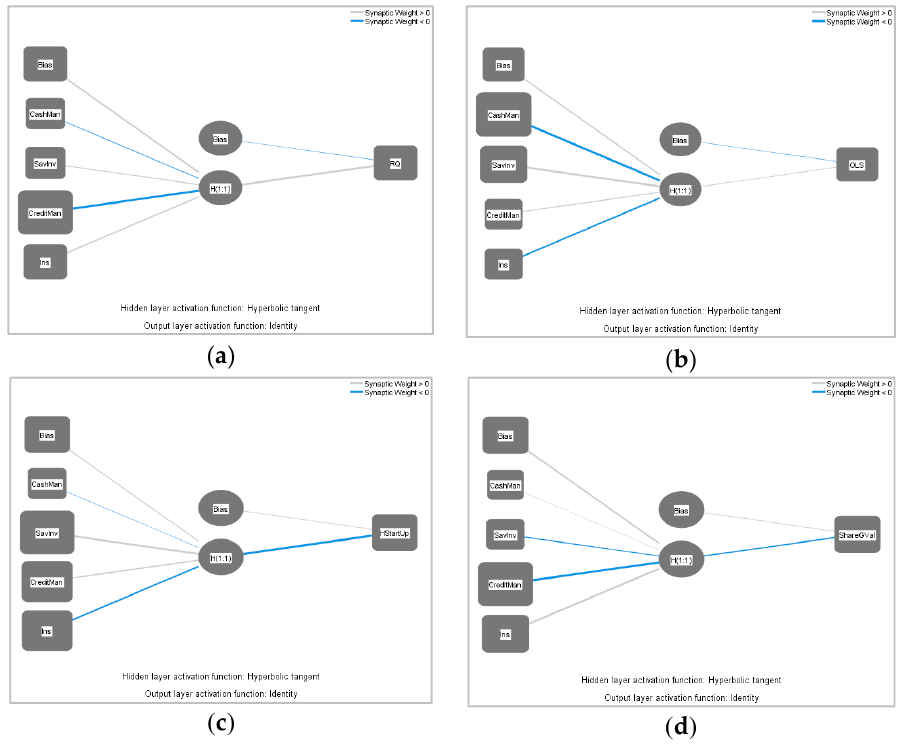
Figure 2. Neural network diagrams for: ( a ) Model A; ( b ) Model B; ( c ) Model C; ( d ) Model D (designed by the authors).